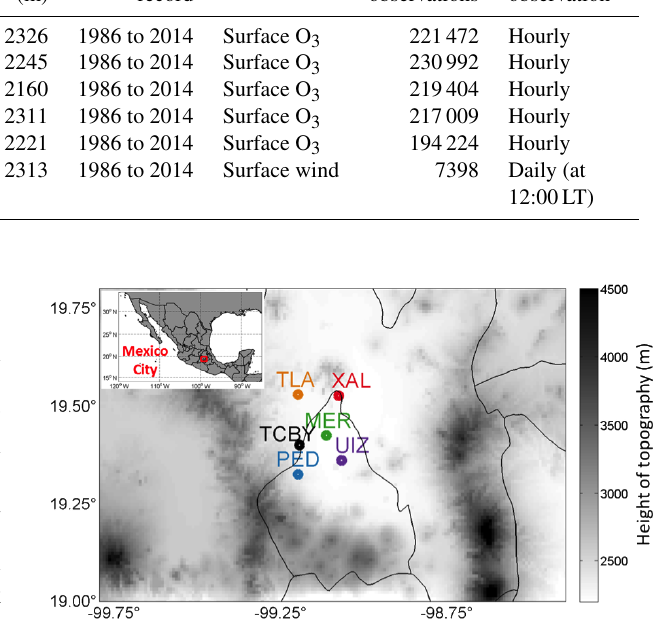
Figure 1. Locations of RAMA surface ozone stations used in this study (colored dots; abbreviations defined in Table 1) and topo- graphic height (shaded, in m) of the Mexico City metropolitan re- gion. State boundaries shown as black contours. Surface meteorol- ogy station at Tacubaya (TCBY) also indicated. The inset in the upper right corner shows the location of Mexico City within Mex-